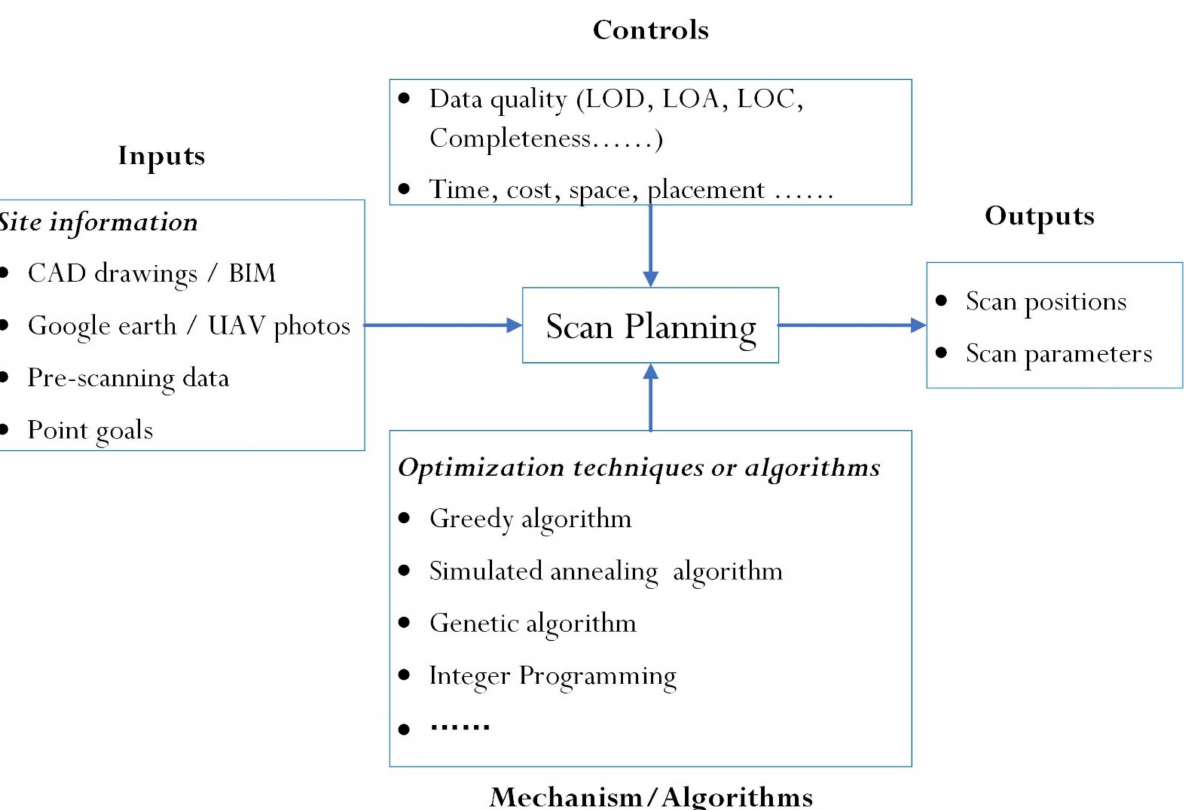
Figure 11. The functional model of scan